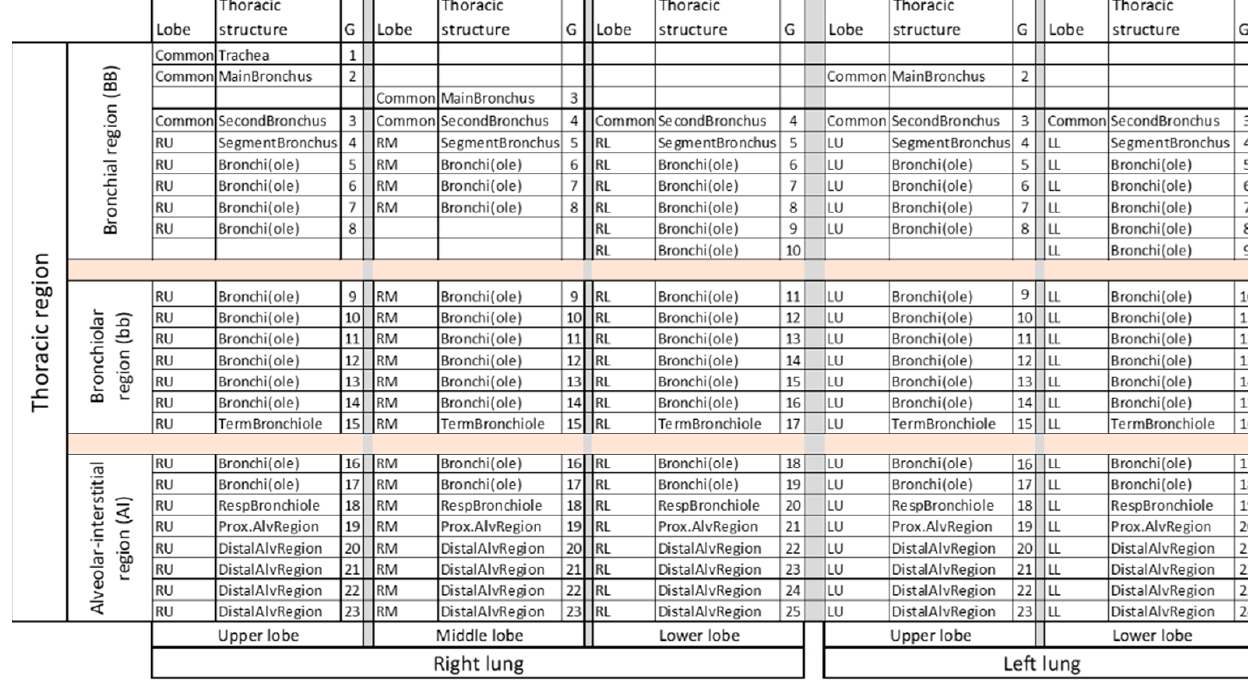
Figure 3. Anatomical structure of the thoracic region according to Yeh/Schum 5-Lobe model applied in the ARAP deposition simulation. Common structures are indicated on the far left. G, generation number; RU, right upper; RM, right middle; RL, right lower; LU, left upper; LL, left lower.